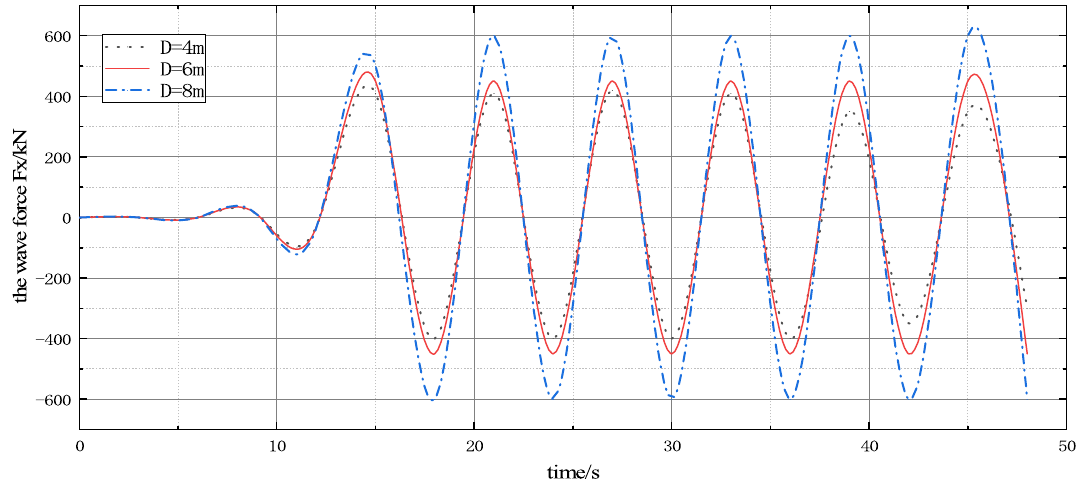
Fig. 8 The time history curve of FX under different pile foundation diameter